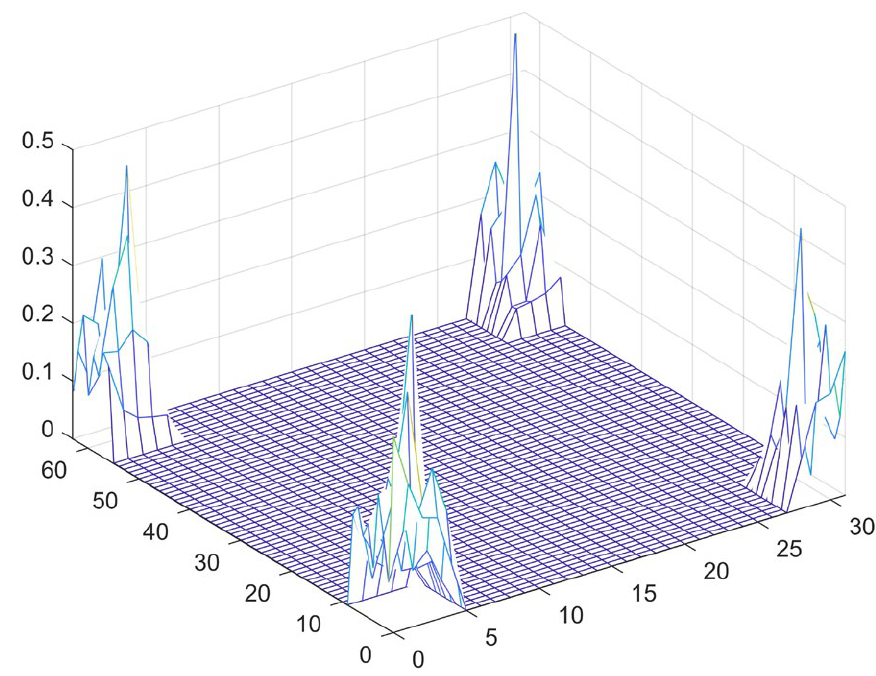
Figure 9. Generated two-dimensional discrete data after first smoothing.